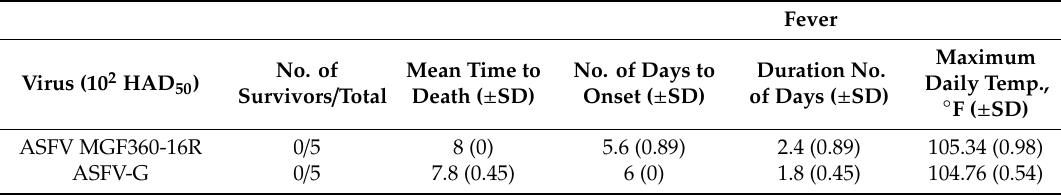
Table 1. Swine survival and fever response following infection with ASFV MGF360-16R and parental ASFV-G.